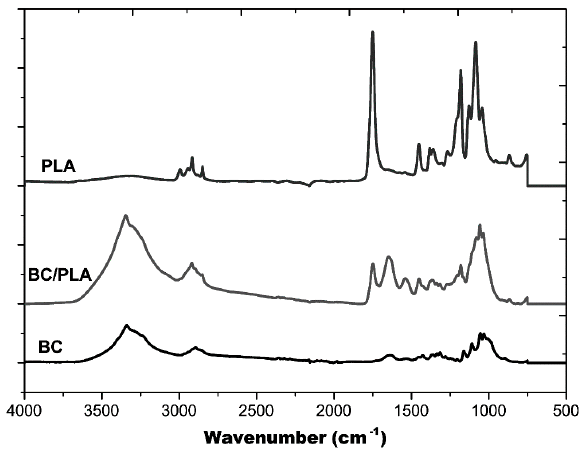
Figure 3. FTIR spectra of (top to bottom): pure BC, BC/PLA nanocomposite, and pure PLA.